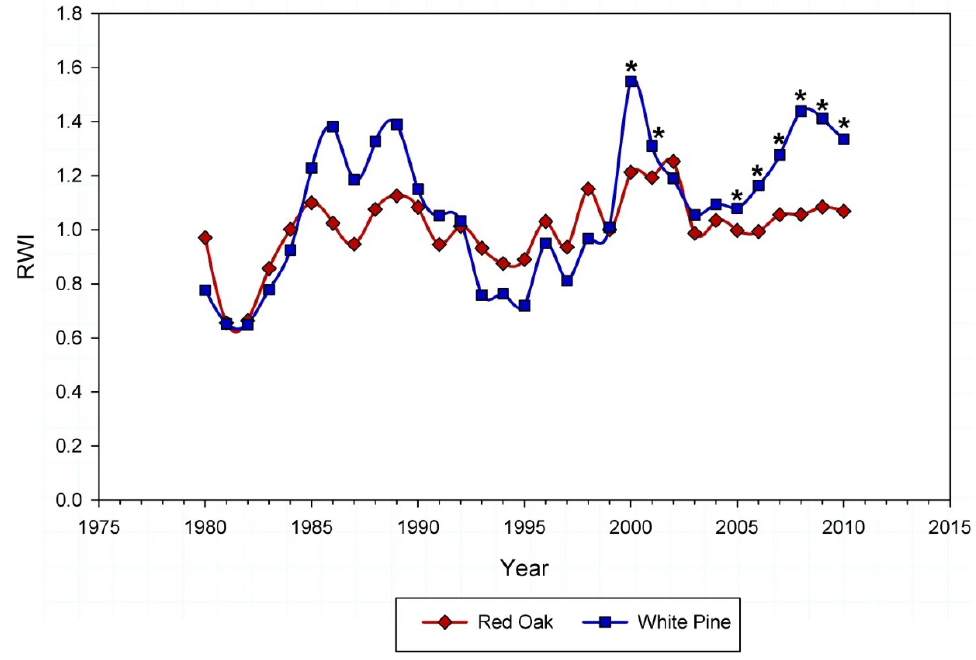
Figure 3. Region-wide Quercus and P. strobus ring width index (RWI) dendrochronologies pooled from 13 sites in eastern Massachusetts from 1980–2010; distinct divergence